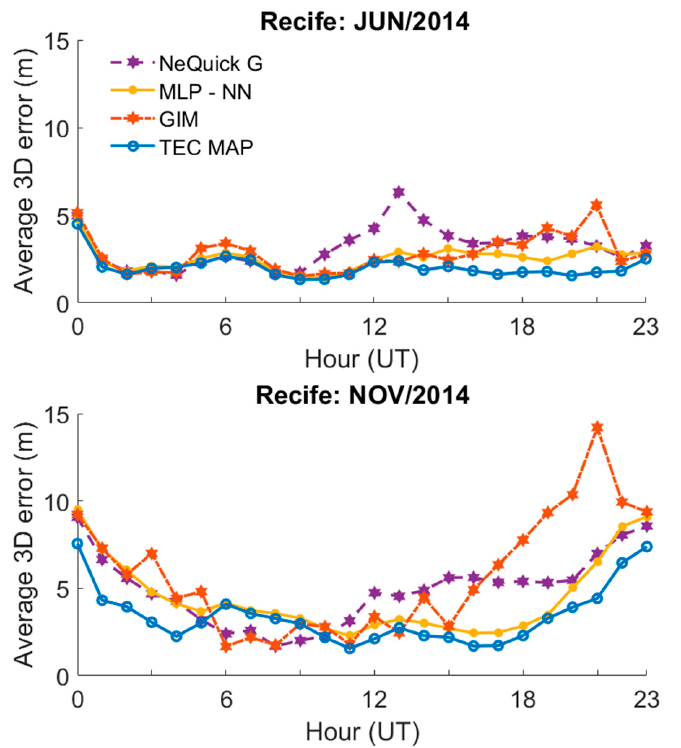
Figure 12. Average 3D error as function of the hour for the station in Recife ( bottom panels ) during the months of June ( upper panel ) and November ( bottom panel ) for the year 2014.